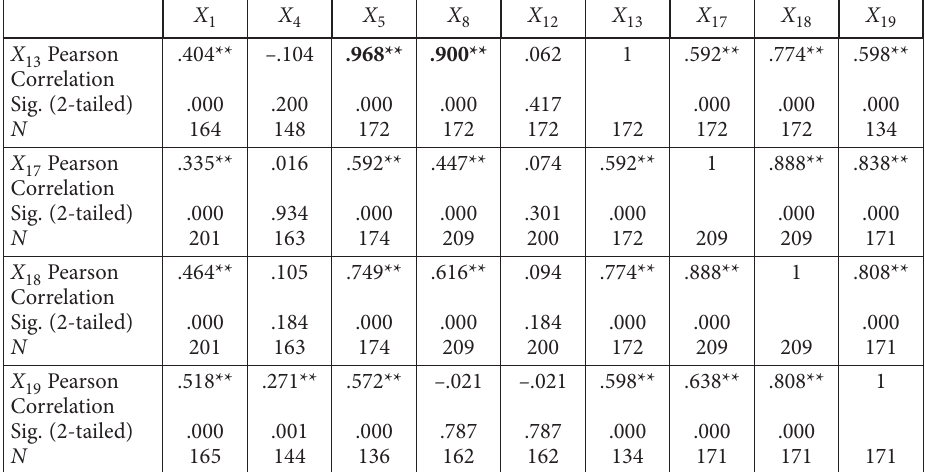
Table 4. Correlation matrix of indicative variables Y 1 Pearson Correlation Sig. (2-tailed)